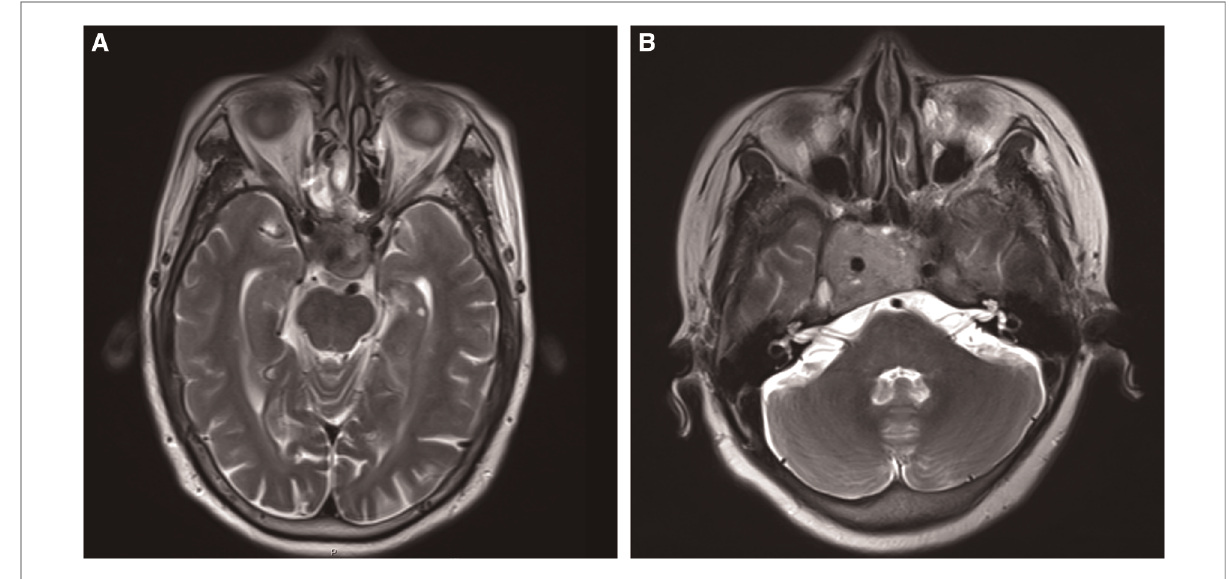
FIGURE 1 ( A,B ) T2-weighted images of nonfunctional pituitary adenomas with Knosp grades 3 and 4,